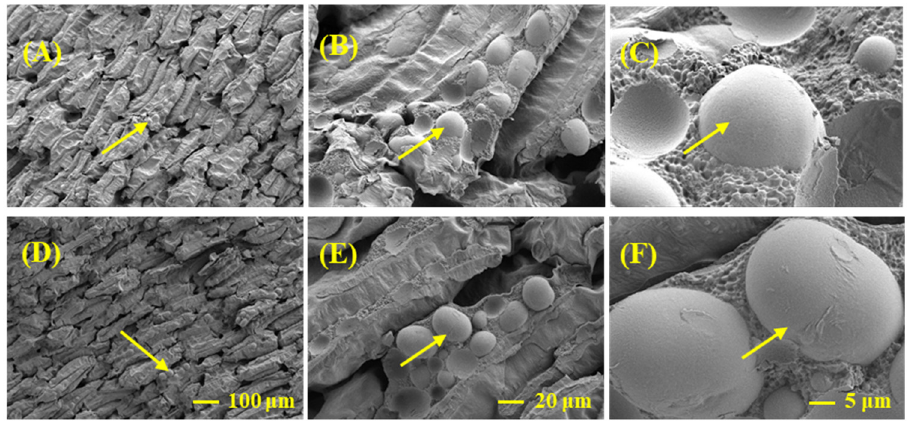
Figure 4. Scanning electron microscopy (SEM) image of mature grains in two broad bean genotypes, Lixiyicun ( A – C ) and Cixidabaican ( D – F ), at 100- ( A , D ), 500- ( B , E ), and 2000-fold ( C , F ) magnification times, respectively. Arrows represent the starch granules.